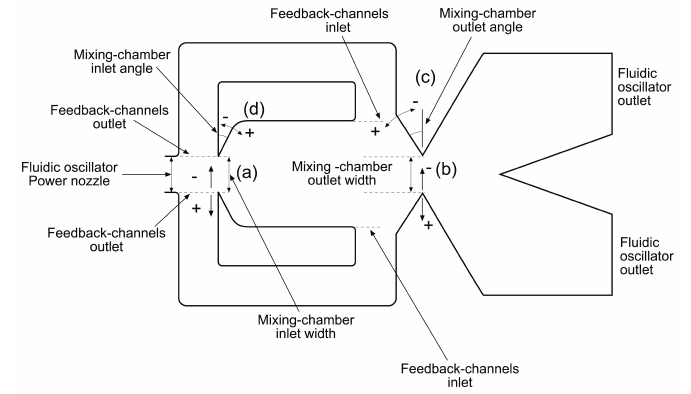
Figure 1. Fluidic oscillator mixing chamber internal dimensions